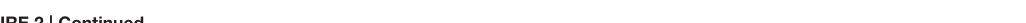
FIGURE 2 | Continued Stage 1: Preparations for the integration of the metabolomic data. (A) First, the detected metabolites need to be matched to the metabolite ID used in the model. This step is simplified if the metabolomic data are annotated with standard metabolite IDs [e.g., from KEGG (Ogata et al., 1999) or HMDB (Wishart et al., 2013)]. (B) Check if transport and exchange reactions exist in the model for each of the matched metabolites using the model metabolite ID. In case of the human genome-scale reconstruction [Recon 2 (Thiele et al., 2013)], you can check for reactions using the virtual metabolic human database (VMH, http://vmh.life) or directly in your model with the COBRA toolbox function findRxnsFromMets .The illustrated VMH query for glutamine shows two of the glutamine transport reactions (highlighted in blue) and the exchange reaction (highlighted in green) of glutamine. Exchange reactions are by definition written as in the given example. (C) Transport reactions need to be identified as comprehensively as possible from the literature. Based on the information gathered about the transport mechanisms, by which a metabolite is transported into and out of the cell, the transport reactions can be formulated. The transport and exchange reactions can be added to the model using rBioNet (Thorleifsson and Thiele, 2011).